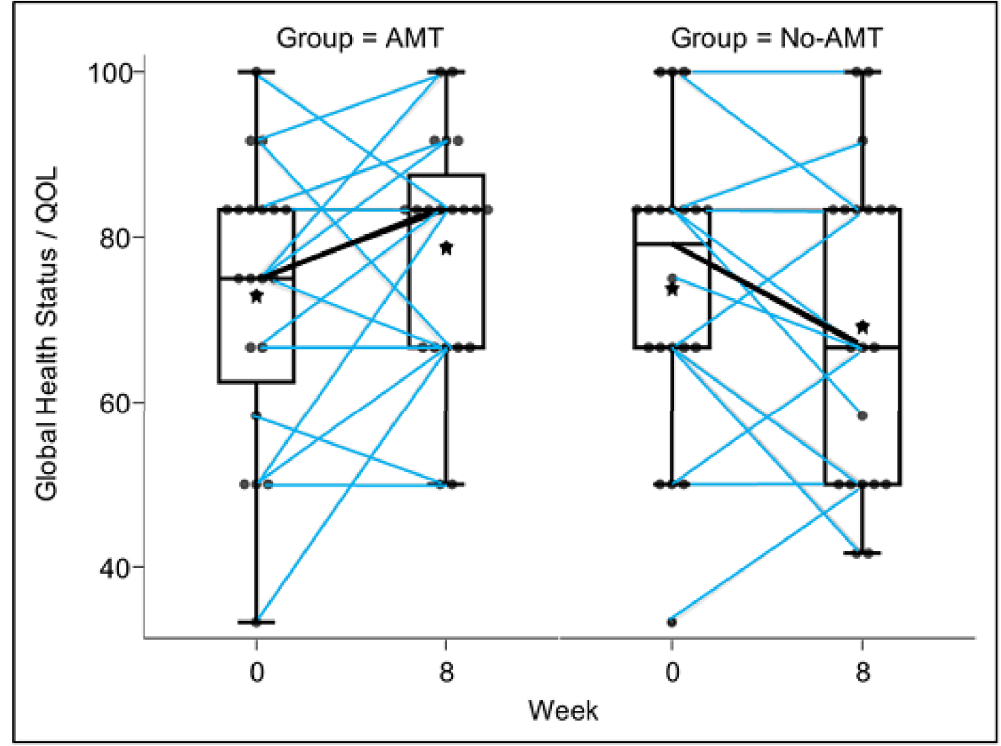
Fig 2. Changes in Global Health scores measured by using the EORTC QLQ-C30. AMT = Anma massage therapy.